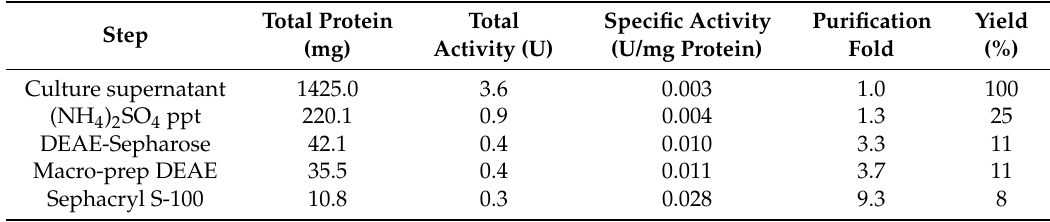
Table 1. Purification of PLA depolymerase from P. tamsuii TKU015 a